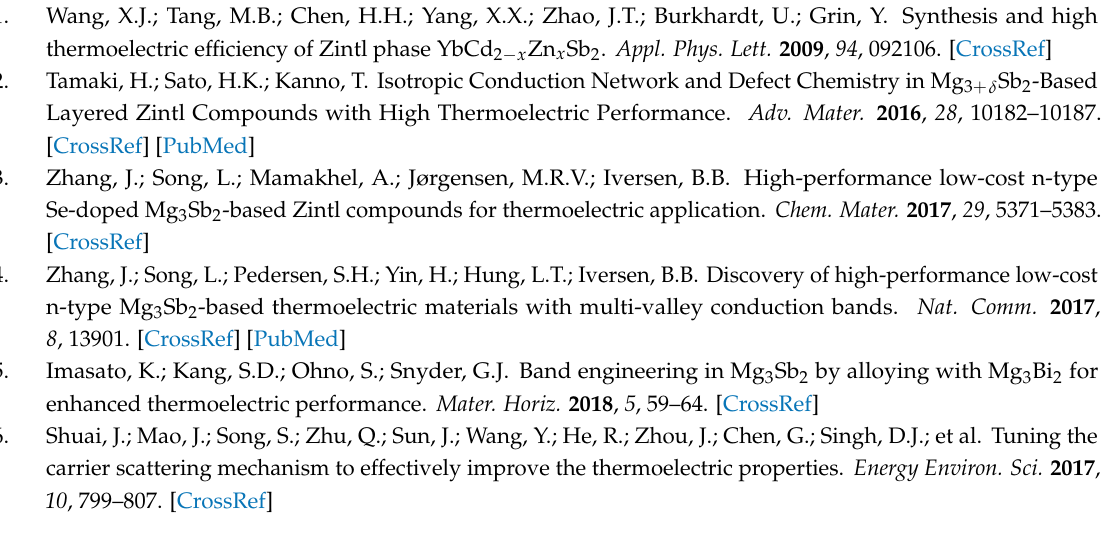
Tables S1–S4: Lattice parameters and R wp values from Reitveld refinements. Figure S1: Reitveld refinement for the (Ca 0.7 Mg 0.3 )Mg 2 Sb 2 sample is representative of data for single-phase samples in the Ca-Mg and Ba-Ca solid solution series. Figure S2: (Ca 0.7 Mg 0.3 )Mg 2 Sb 2 sample is representative of data for single-phase samples in the Ca-Mg and Ba-Ca solid solution series. Figure S3: Rietveld refinement for the (Sr 0.4 Mg 0.6 )Mg 2 Sb 2 sample is representative of data for two-phase samples in the Sr-Mg and Ba-Mg series. Note that the C-graphite peak is from some residual graphite foil on the surface and edges of the sample (not in the sample). Figure S4: Rietveld refinement for the (Sr 0.4 Mg 0.6 )Mg 2 Sb 2 sample is representative of data for two-phase samples in the Sr-Mg and Ba-Mg series. Note that the C-graphite peak is from some residual graphite foil on the surface and edges of the sample (not in the